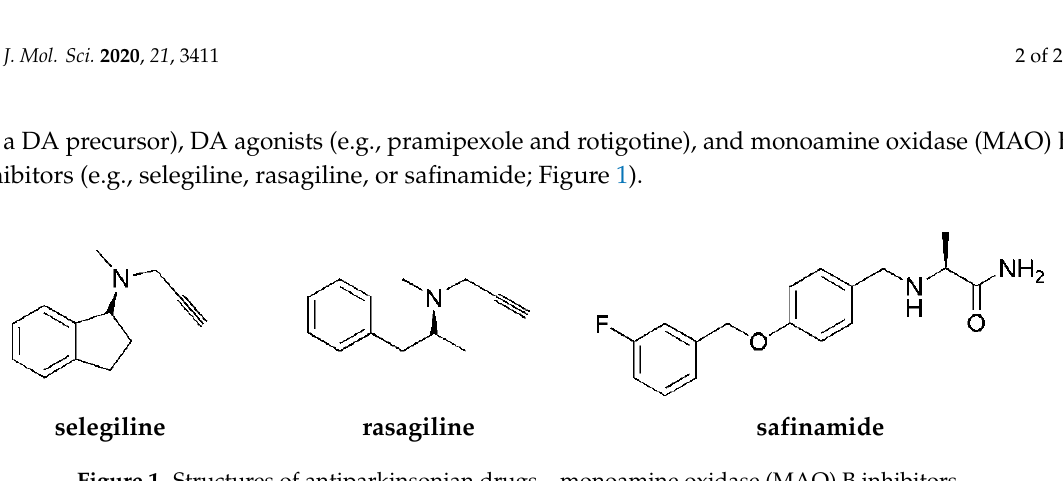
Figure 1. Structures of antiparkinsonian drugs—monoamine oxidase (MAO) B inhibitors.